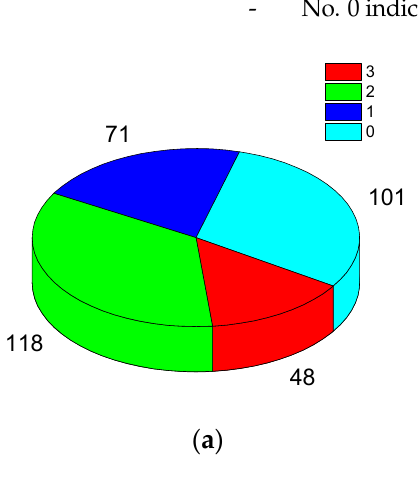
Figure 8. Identifying similar equations [43]: ( a ) average instantaneous velocity; ( b ) average angular velocity.